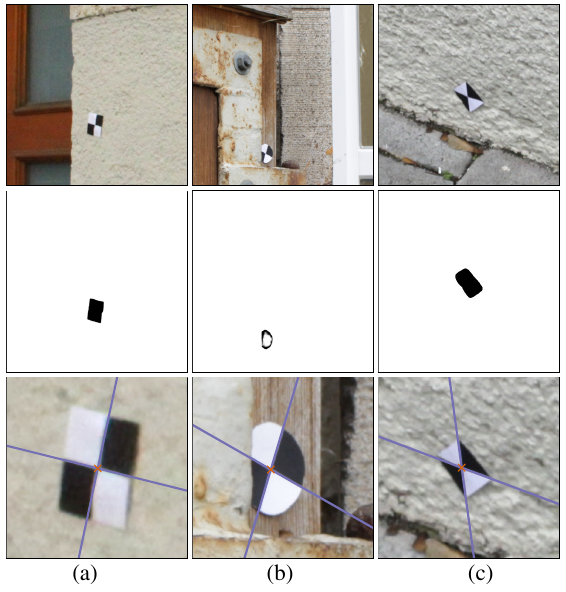
Figure 1. Qualitative results of control point detection. Top row: input images, central row: prediction, bottom row: center